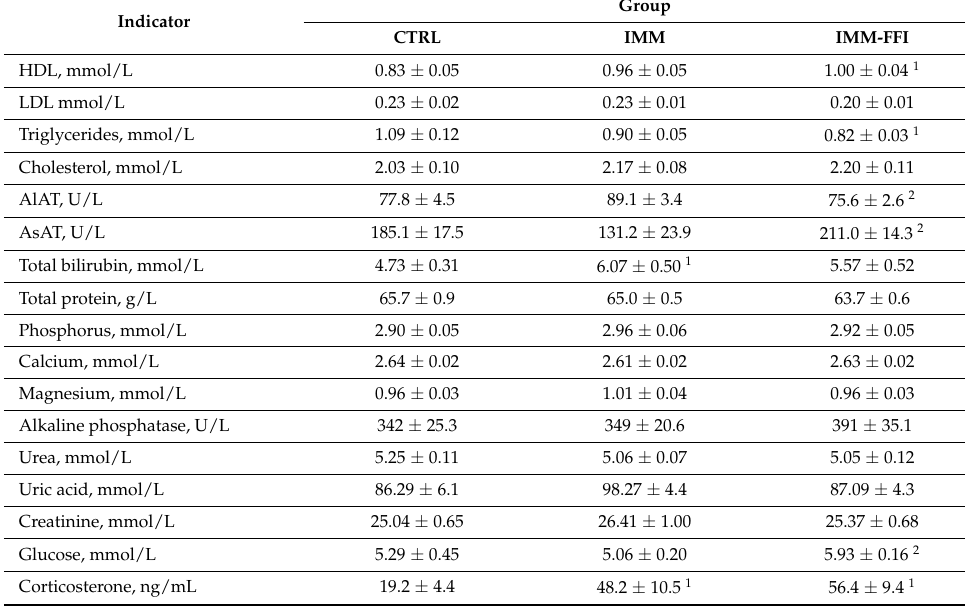
Table 3. Biochemical blood indicators of